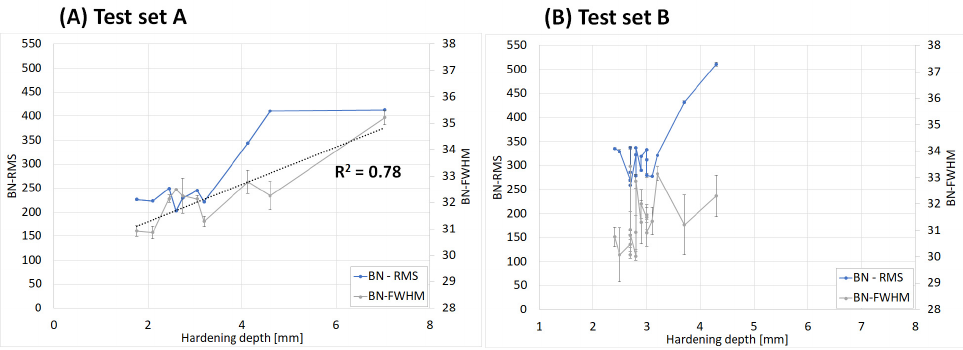
Figure 3. Barkhausen noise RMS and FWHM versus the hardening depth, ( A ) set A and ( B ) set